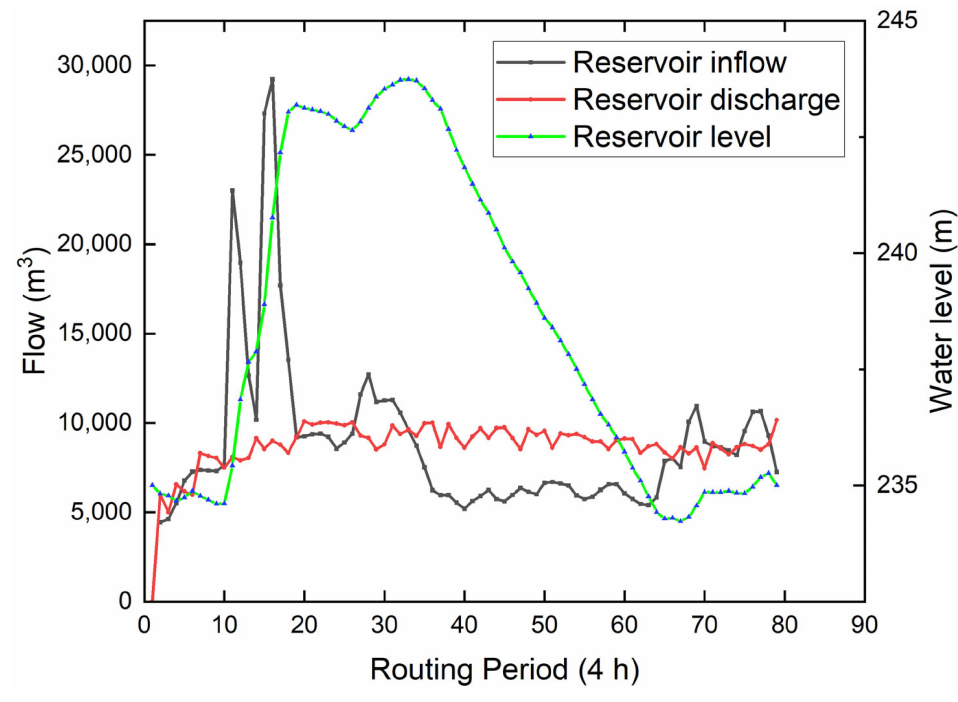
Figure 7. Xiaolangdi Reservoir operation process.